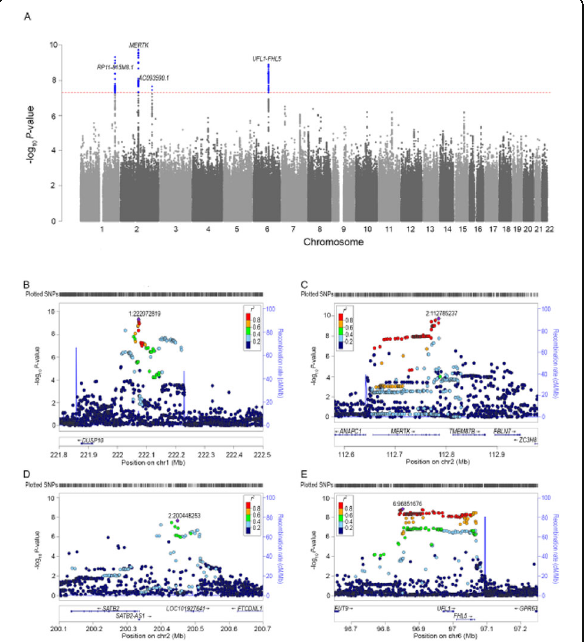
Fig. 1 (abstract P0502). See text for